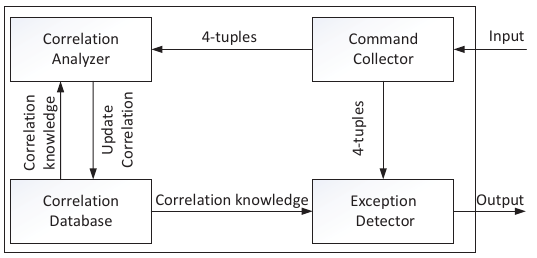
Figure 5. The structure of detection